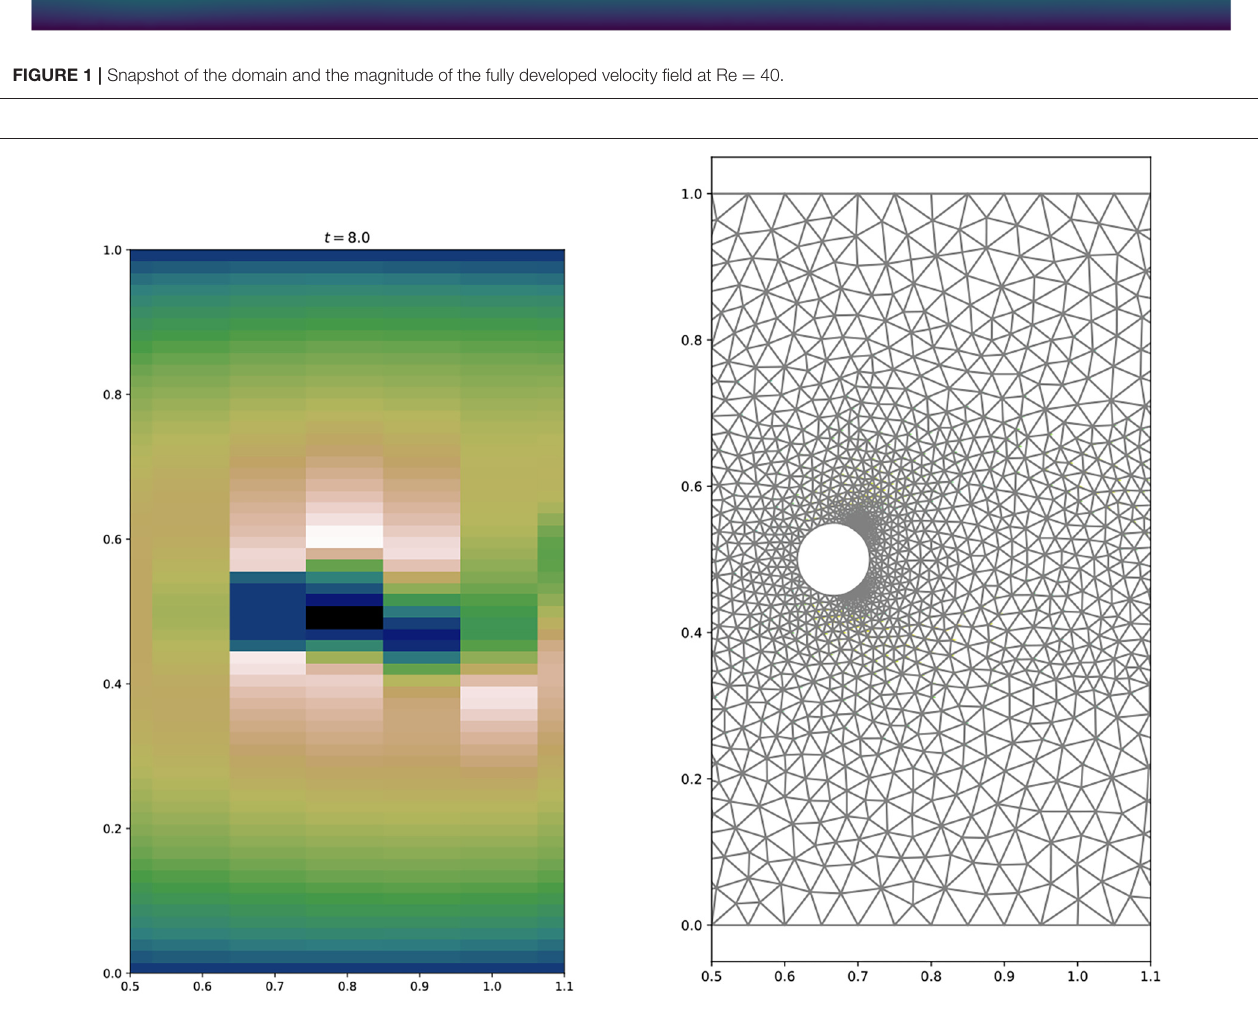
FIGURE 2 | Close up view of the computational domain with the FEM mesh (right) and the data representation on the tensorized mesh (left).